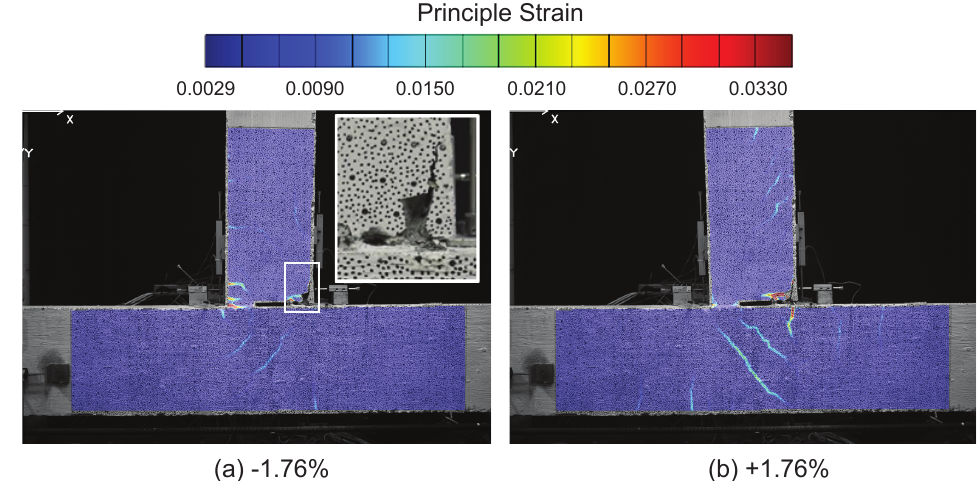
Figure 10. DIC results at a drift level of ±1.76%.